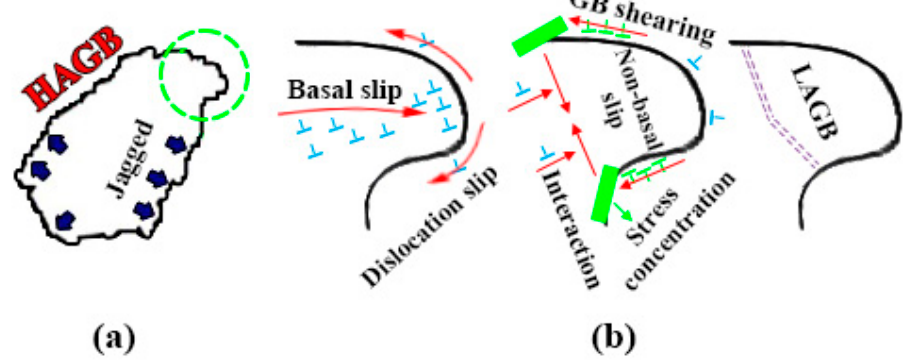
Figure 11. Schematic diagram of discontinuous dynamic recrystallization (DDRX) process. ( a ) Schematic diagram of a typical grain where a DDRX process is taking place; ( b ) Schematic diagram of DDRX process.